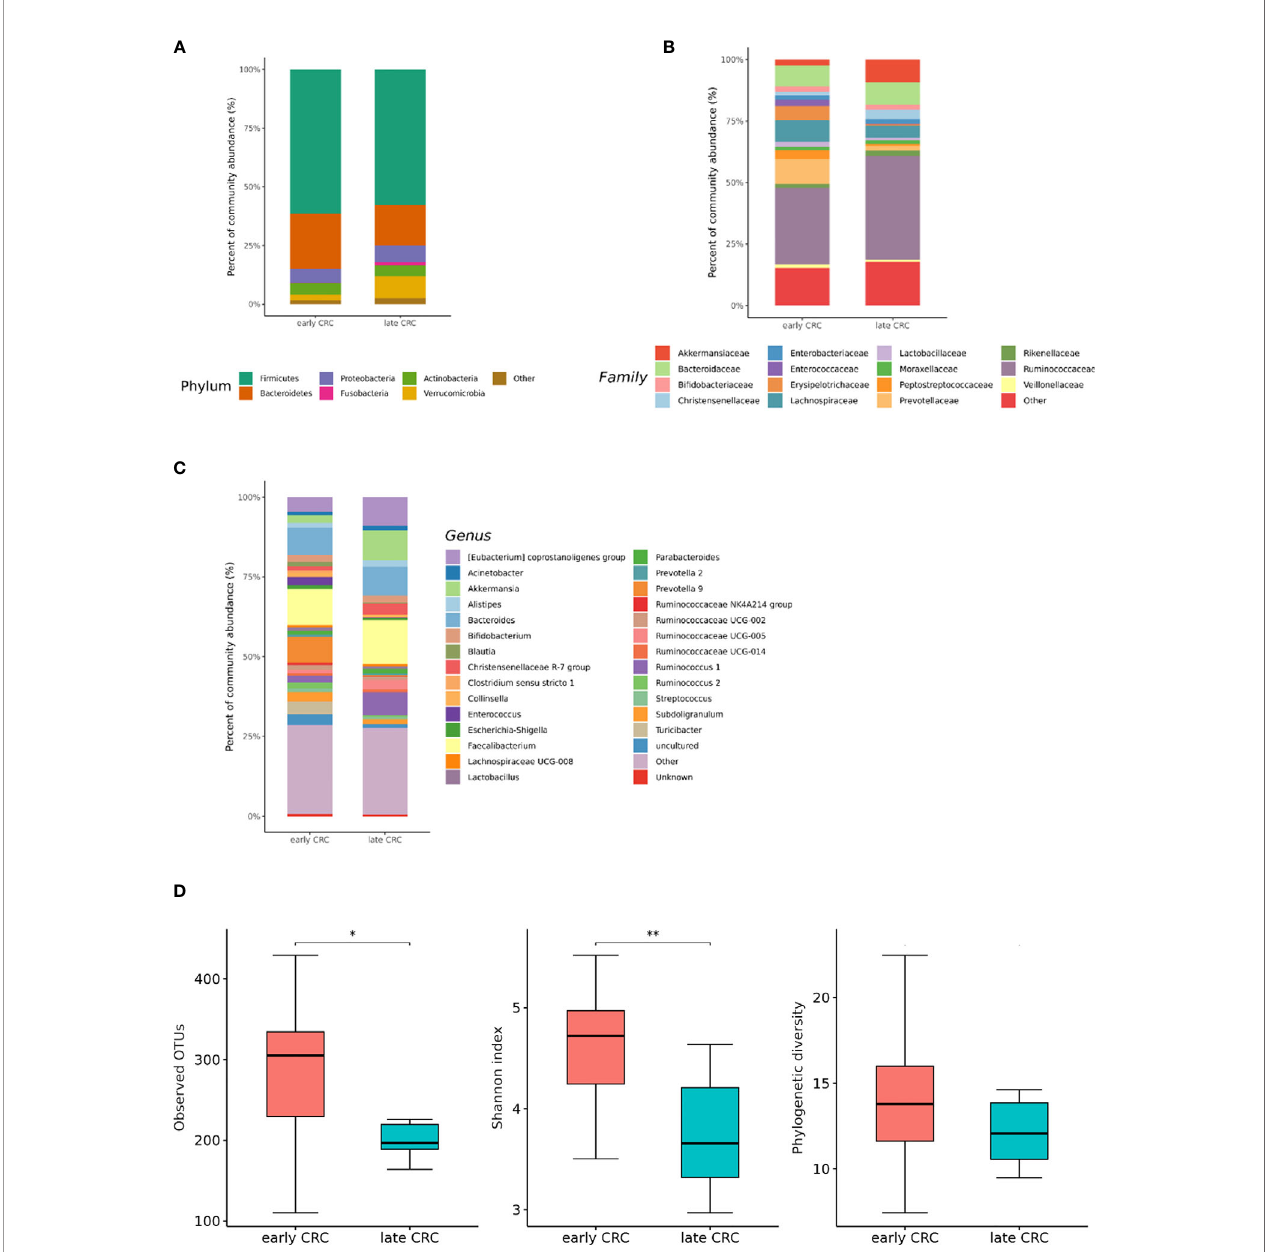
FIGURE 6 | Relative abundance plots of gut microbe-derived extracellular vesicles of early CRC (n = 62) and late CRC (n=8) (A) at the phylum, (B) family, and (C) genus levels. (D) Boxplots of alpha diversity indices comparing late CRC with early CRC in gut microbe-derived extracellular vesicles. ** p < 0.01 and * p < 0.05. CRC; colorectal cancer, OTU; operational taxonomic